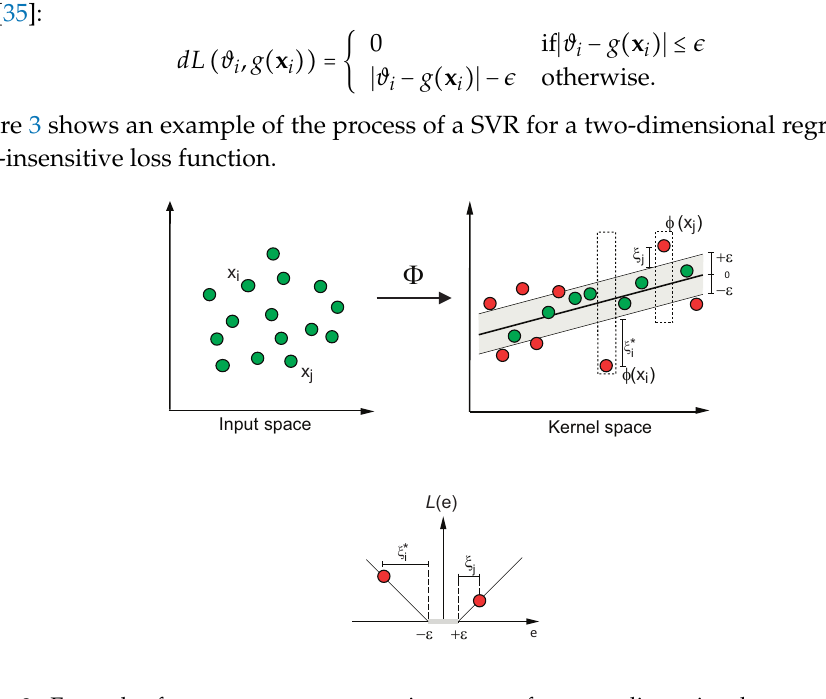
Figure 3. Example of a support vector regression process for a two-dimensional-regression problem, with an (cid:101) -insensitive loss